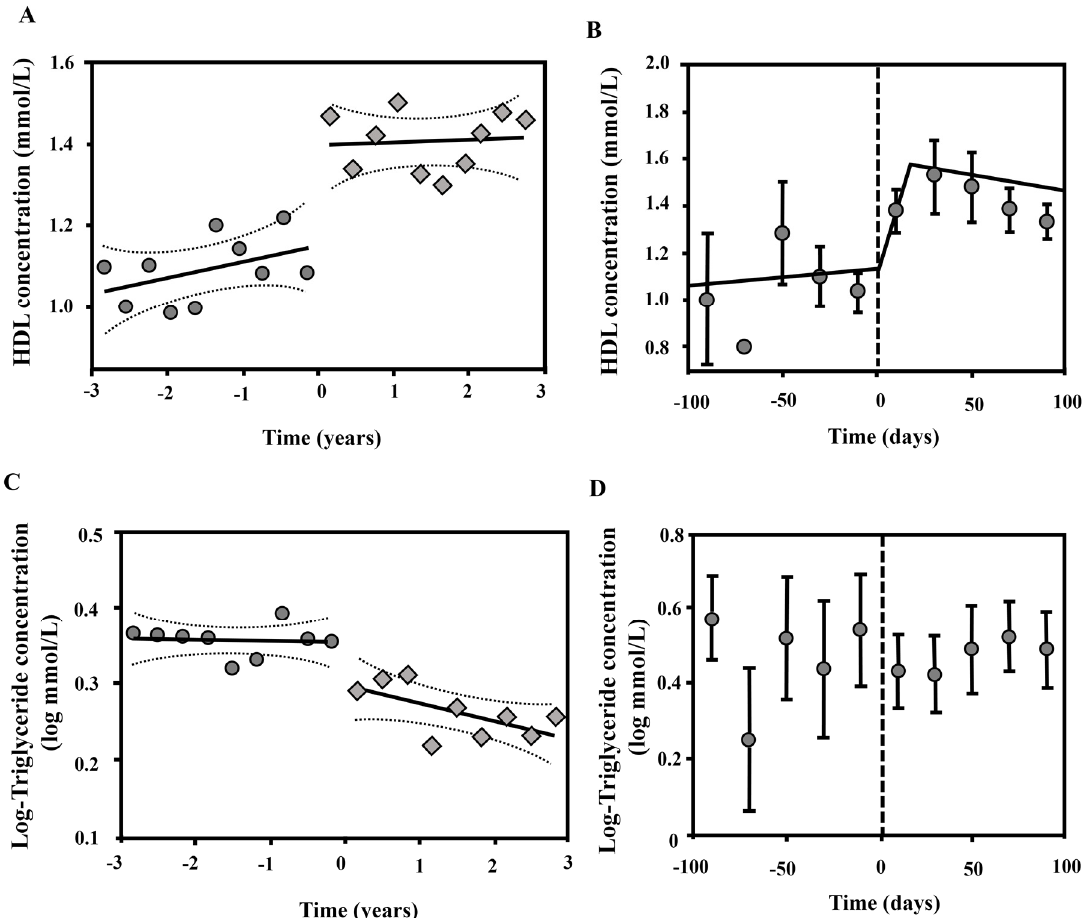
Figure 3. HDL and triglyceride concentration with respect to time prior to and following kidney transplantation. ( A ) Linear regression analysis of HDL concentration in the 3 years prior to and following kidney transplantation; ( B ) Piecewise 3 segment linear regression of HDL concentration in the 100 days prior to and following kidney transplantation; ( C ) Linear regression analysis of log triglyceride concentration in the 3 years prior to and following kidney transplantation; ( D ) Log triglyceride concentration in the 100 days prior to and following kidney transplantation. Symbols represent mean values for all observations within 4 month time intervals ( A , C ) or 20 day time intervals ( B , D ) represent the standard deviation for all observations within a period. To convert values HDL to mg/dL, multiply by 38.67. To convert values for triglycerides to mg/dL, multiply by 88.57. Abbreviations: HDL, high density lipoprotein.